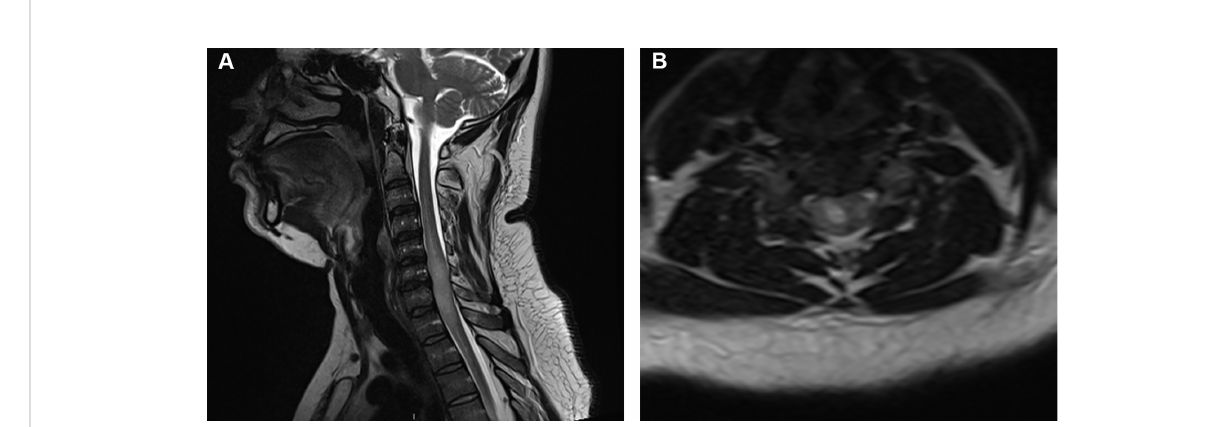
FIGURE 2 Adult patient with an intramedullary astrocytoma seen on (A) sagittal T2-weighted MRI and (B) axial T2-weighed MRI extending from the C4 to T3 vertebral levels with effacement of the subarachnoid cerebrospinal fl uid. The patient presented with lower limb paralysis and loss of bladder and bowel function. Intra-operatively, a subtotal resection was performed with removal of visible tumor; however, the tumor was noted to be in fi ltrative. Pathology revealed an H3K27M- altered diffuse midline glioma resulting in a WHO Grade 4 diagnosis, although the histological appearance resembled anaplastic